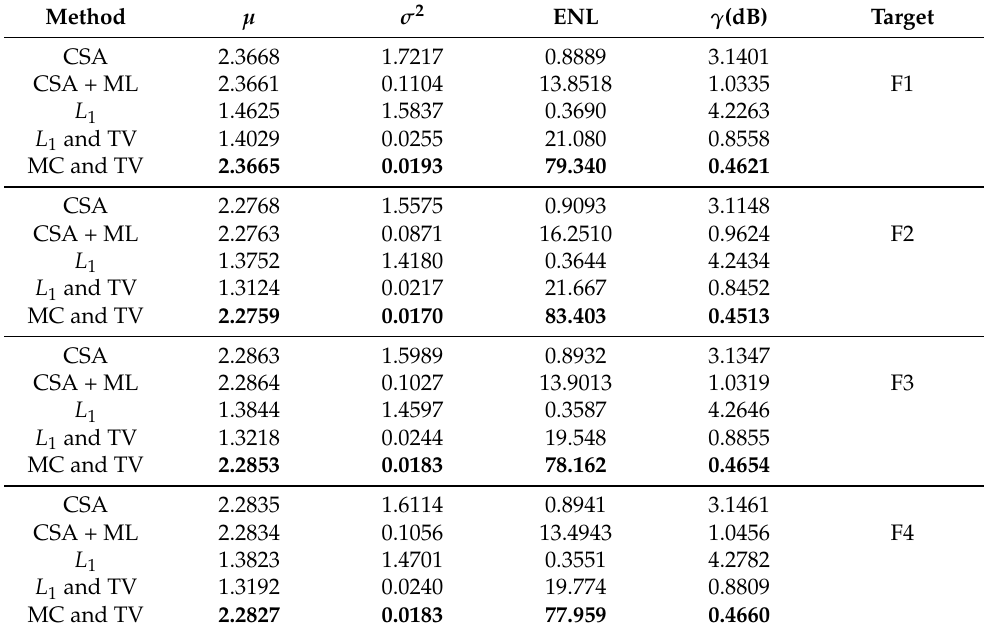
Table 2. The radiometric resolution of four distributed targets in experiment 2 for the five methods.